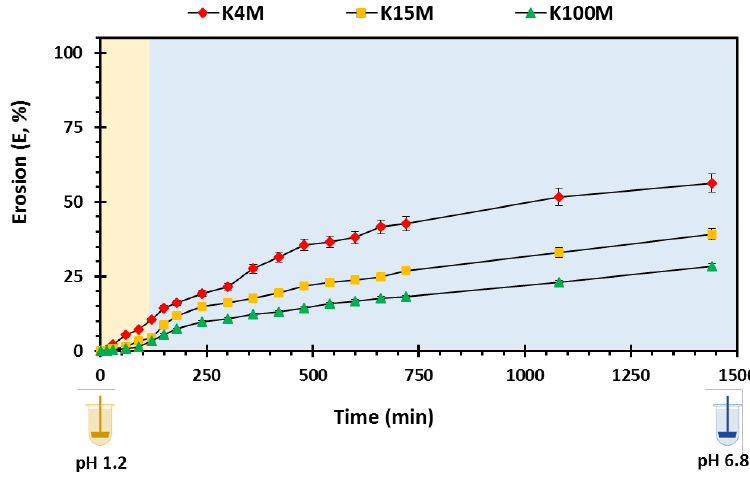
Figure 10. Overall matrix erosion vs, time profile of 3D printed HPMC matrix tablets.